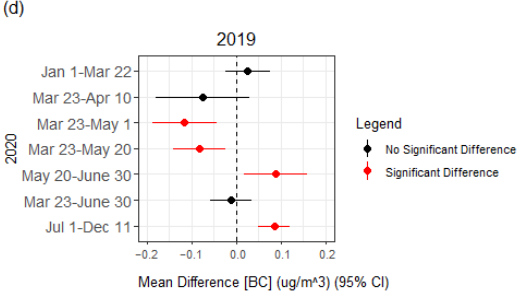
Figure 15. Post hoc test results for intra-annual and interannual BC concentration comparisons at the Near Road and Taft sites: ( a ) intra-annual at Near Road; ( b ) intra-annual at Taft; ( c ) interannual at Near Road; ( d ) interannual at Taft. The circles represent the difference in mean hourly BC concentration between the two time periods on each axis along with the 95% confidence interval (e.g., top left of top figure: (mean BC 23 March–10 April) − (mean BC 1 January–22 March) = 0.131 ug/m 3